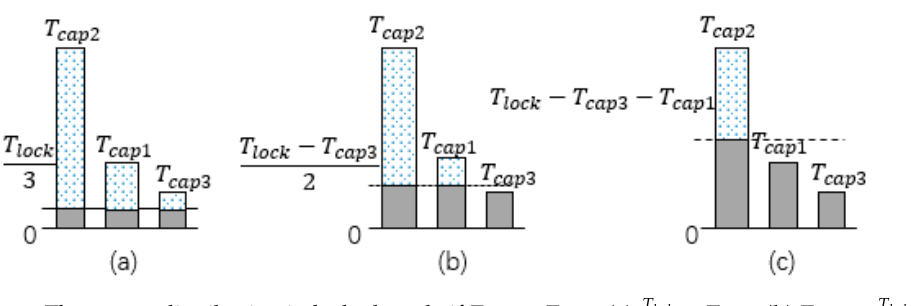
≤ T ≤ T lock ≤ cap 3 ; ( b ) T cap 3 3 3